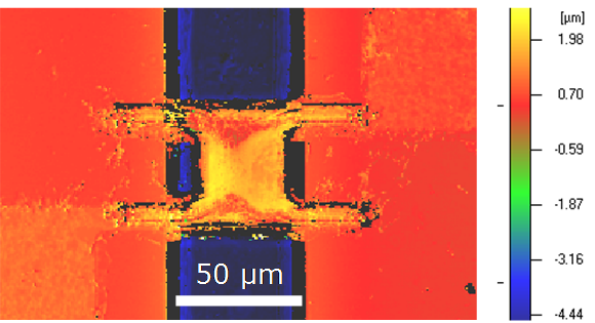
Figure 7. Confocal microscopic view of the surface topography of a microbolometer pixel with a sensitive layer containing aligned tellurium